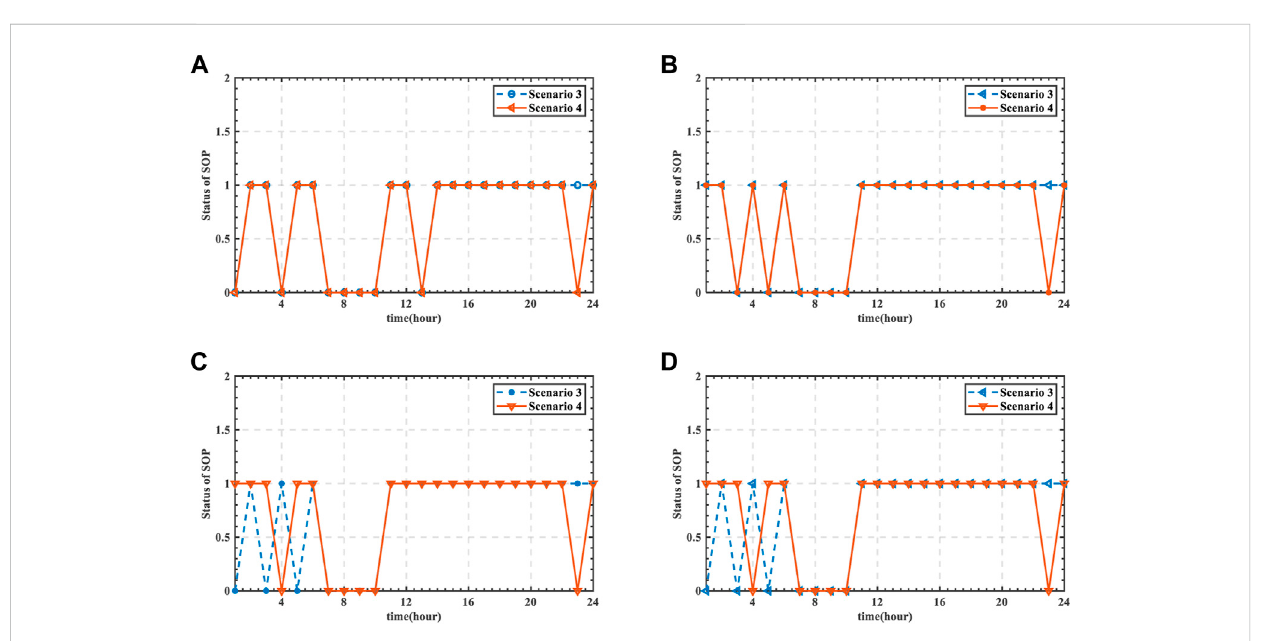
FIGURE 20 Status of SOP for the shortest travel time